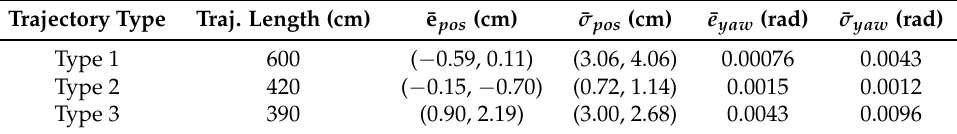
Table 3. Advanced simulation results set 1.